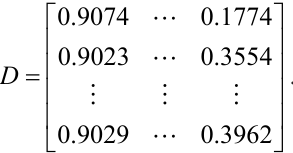
Representative indicator of each group cluster